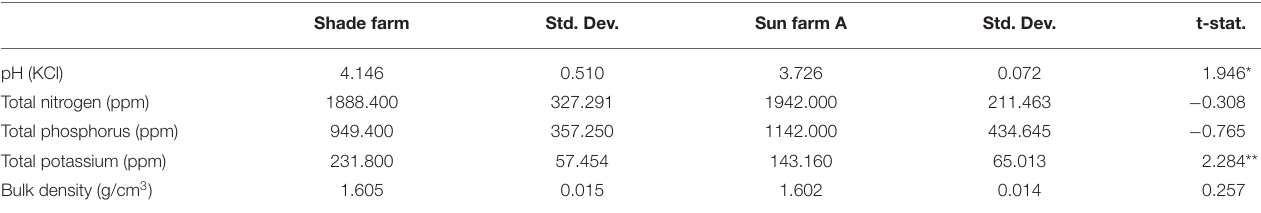
TABLE 1 | T -test of soil analysis in shade farm vs. sun farm A. Shade farm Std.